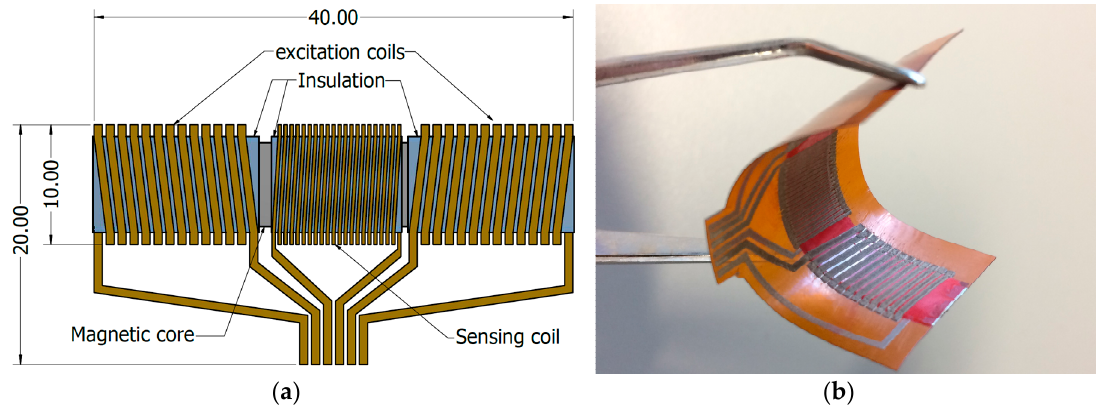
Figure 1. Fluxgate sensor: ( a ) Schematic diagram of the fluxgate sensor with dimensions in mm; ( b ) picture of the flexible pad-printed fluxgate sensor with total thickness less than 300 μ m.